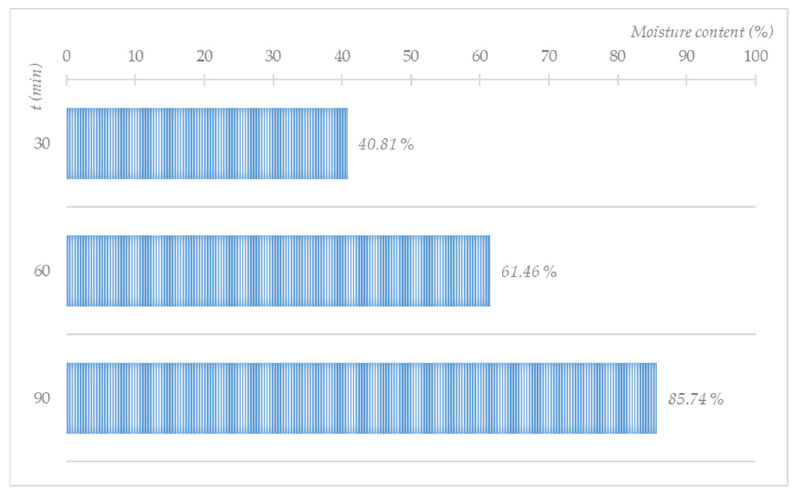
Figure 10. Influence of the treatment with saturated steam (400 g/30 min) on the wetting of a cotton base load (2.0 kg).